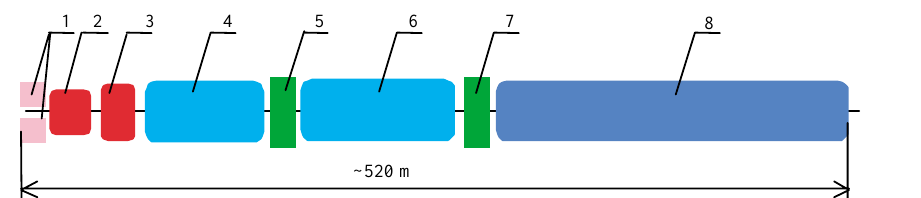
FIG. 1. (Color) General design of the linac. 1: ECR ion sources; 2: 58.3 MHz RFQ; 3: 58.3 MHz IH accelerating structure; 4: superconducting radio frequency structures operating at 58.3 and 116.7 MHz; 5: first stripper ( 12.3 MeV (cid:2) u); 6: SC structures operating at 175 and 350 MHz; 7: second stripper ( 85.5 MeV (cid:2) u); 8: SC structures operating at 700 MHz.